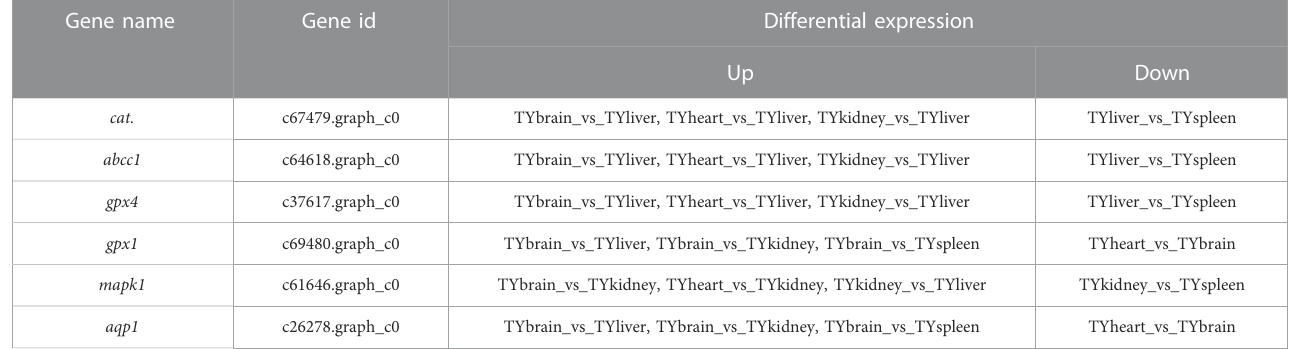
TABLE 1 Differential expression in tissues of six genes involved with salinity-alkalinity